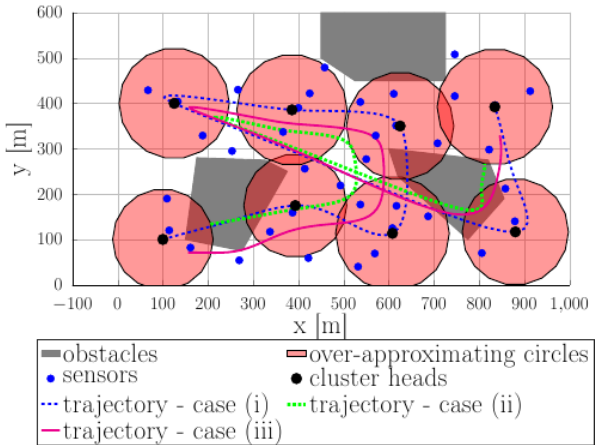
Figure 10. Computed trajectories passing through or near the cluster heads: gray-filled regions—obstacles, semi-transparent red regions—communication areas. semi-transparent red regions—communication areas.